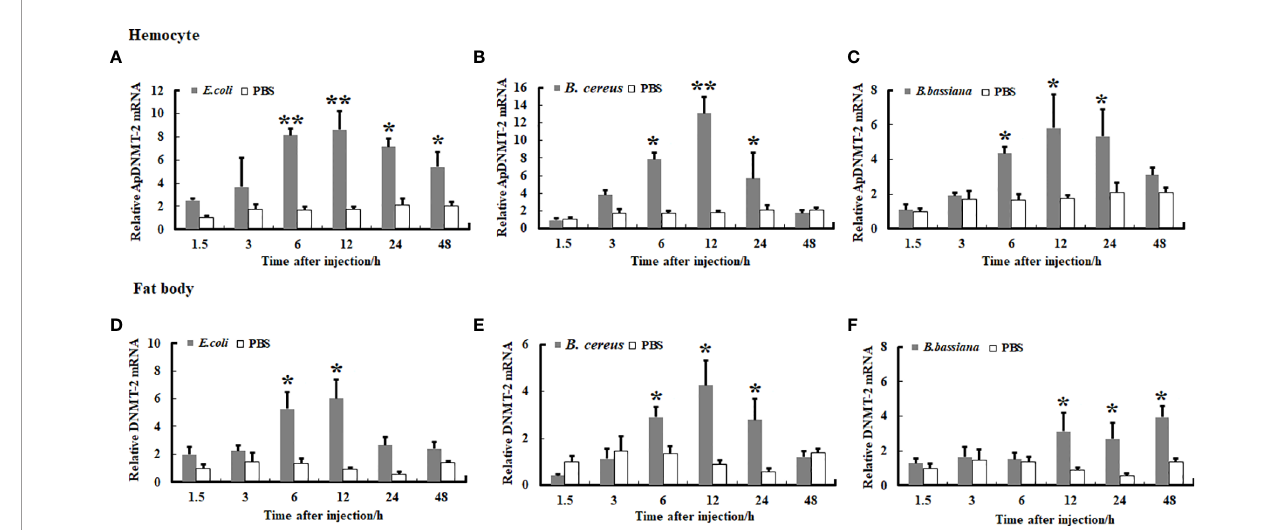
FIGURE 7 | Expression pro fi le of ApDNMT-2 in hemocyte and fat body following microbial challenge. (A) Expression pro fi le following E. coli challenge in hemocyte, (B) Expression pro fi le following B. cereus challenge in hemocyte, (C) Expression pro fi le following B. bassiana challenge in hemocyte, (D) Expression pro fi le following E. coli challenge in the fat body, (E) Expression pro fi le following B. cereus challenge in fat body, (F) Expression pro fi le following B. bassiana challenge in the fat body. PBS was injected as the control. Bars show mean ± S.E. (n = 3), and asterisks indicate signi fi cant differences (* p < 0.05, ** p <